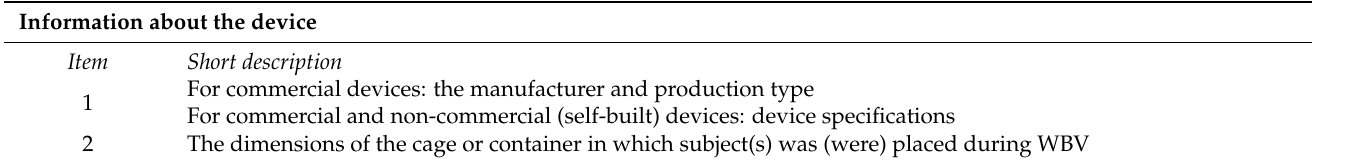
Table 2. Checklist of information to include in WBV studies in animal and/or cell